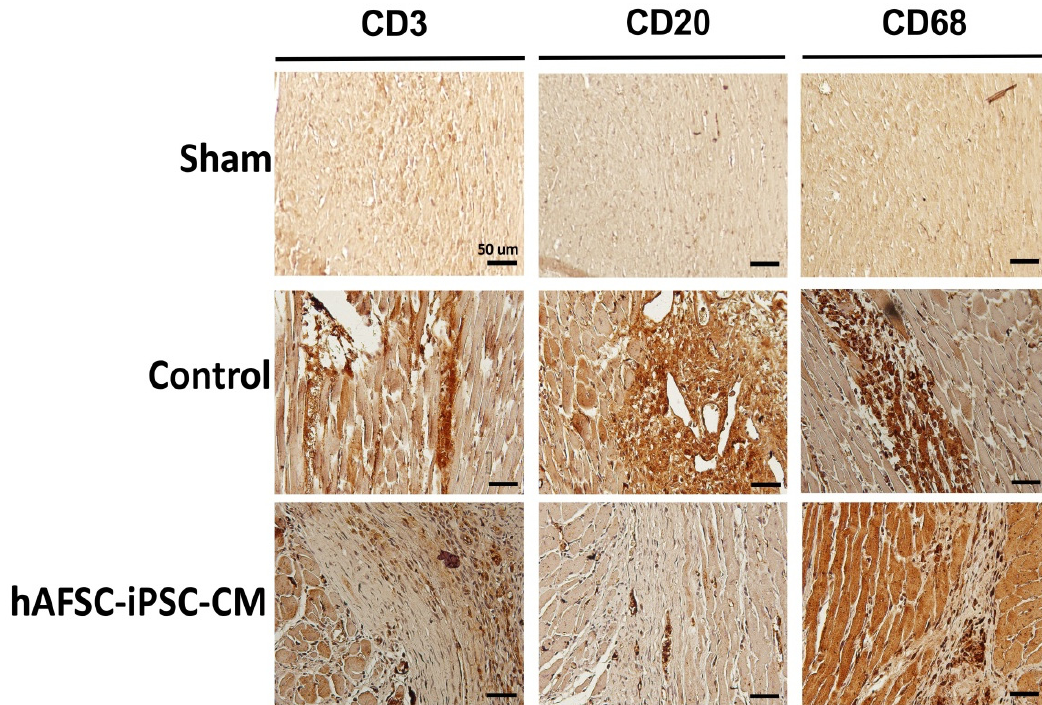
Figure 6. Immune response of the infarcted region. Immunohistochemistry image of rat hearts subjected to myocardial infarction and transplantation of either vehicle (control) or hAFSC-iPSC-CMs at post-transplant 3 weeks. Few CD3 + T lymphocytes, CD20 + B lymphocytes and CD68 + macrophages are seen surrounding the hAFSC-iPSC-CM graft. Comparable numbers of T and B lymphocytes and macrophages were also detected in the infarcted myocardium of the control animals receiving vehicle treatment, but not in the myocardium of the sham animals (i.e., those animals without myocardial infarction). Scale bar, 50 µm.